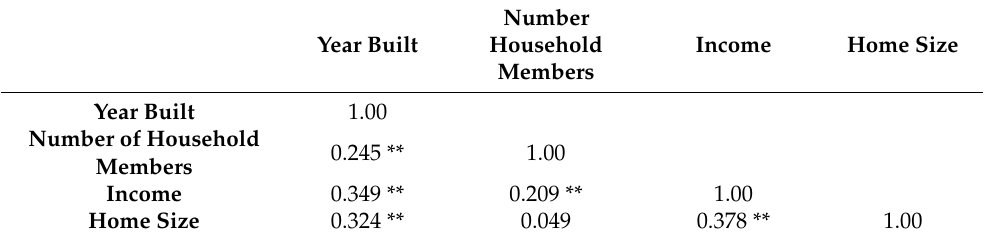
Table 6. Correlation analysis—Hot-Humid Climate (Spearman’s ρ